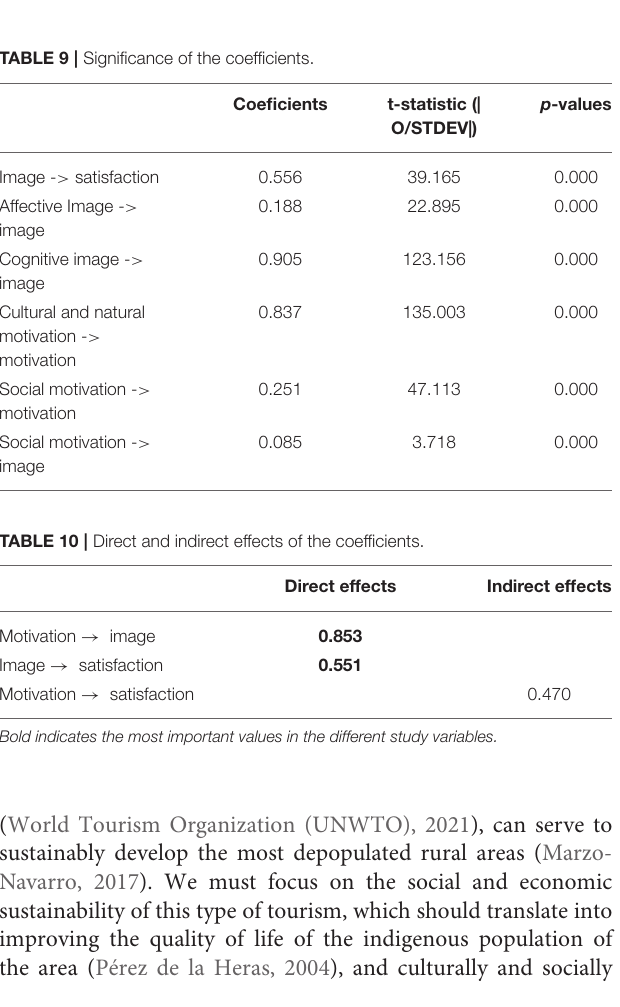
FIGURE 2 | Results.